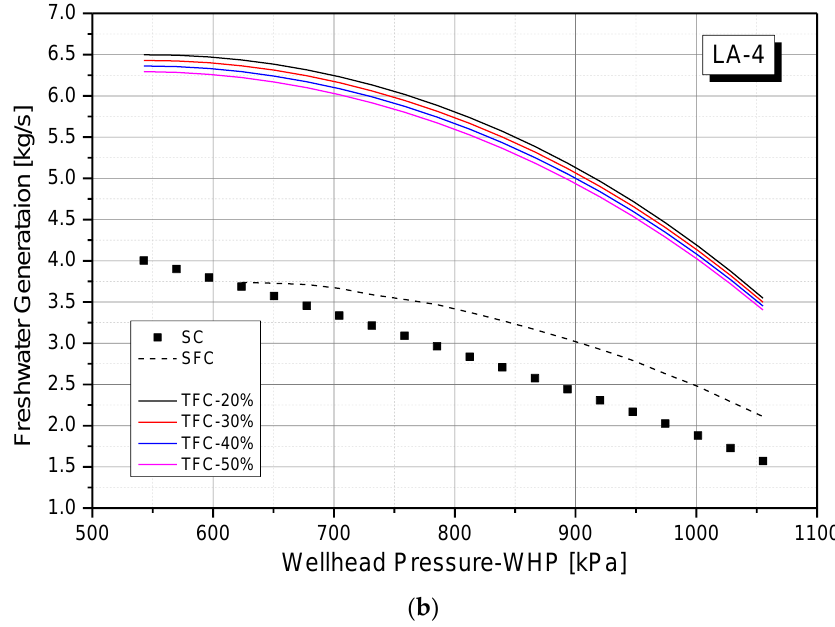
Figure 6. Fresh water generation against wellhead pressure of ( a ) LA-8 and ( b ) LA-4.